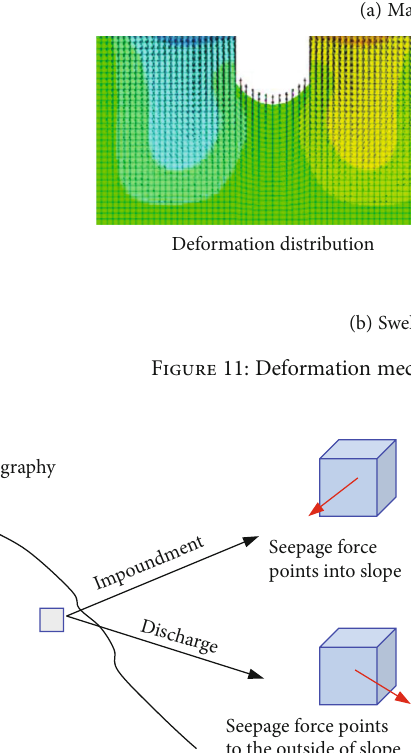
Figure 12: Direction of seepage changes during the operation period.